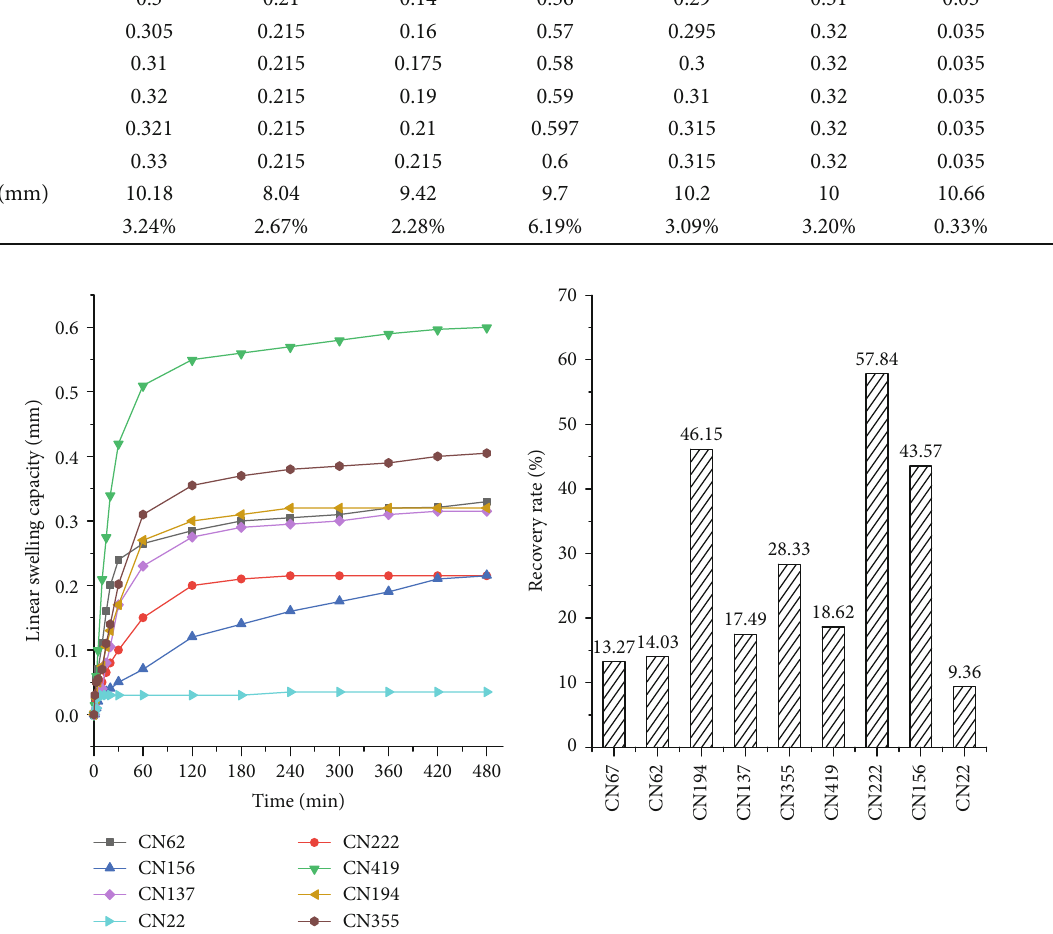
Figure 3: Test results of hydration swelling and dispersion properties of rock samples in Longmaxi